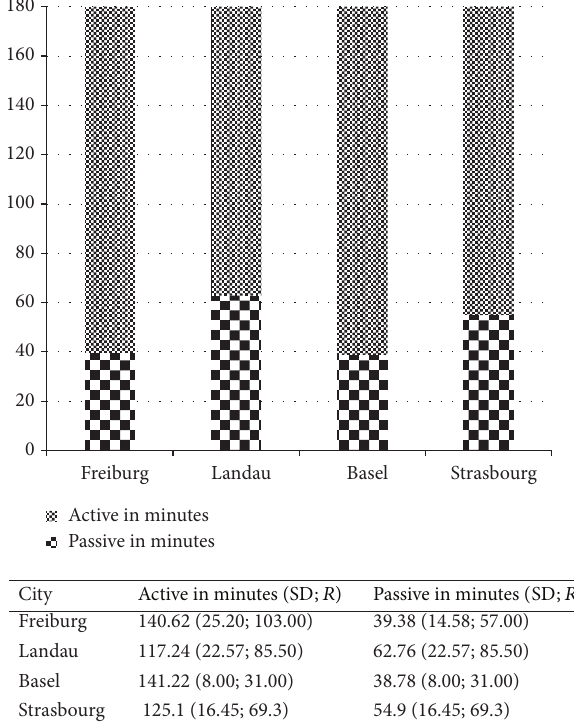
Figure 1: PA in the morning on weekdays (9:00a.m.–12:00 p.m.) differentiated by countries and